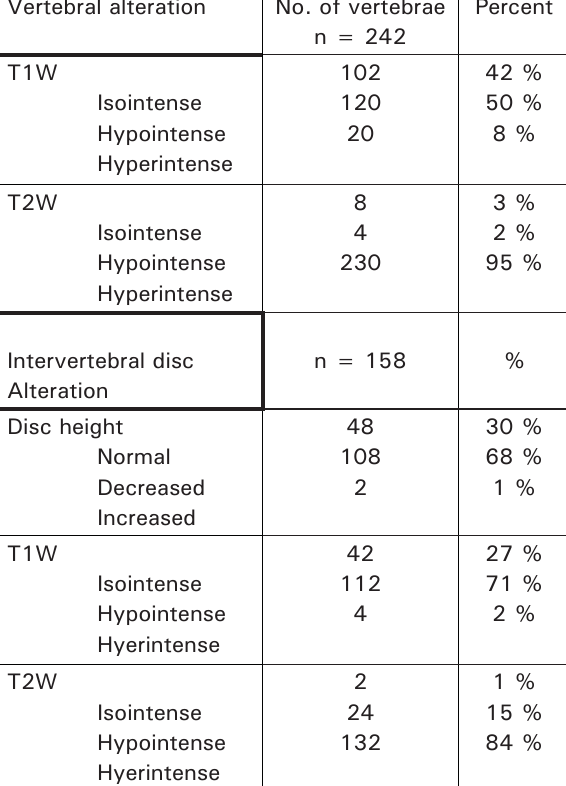
Table 3: Correlation of neurological status with MR